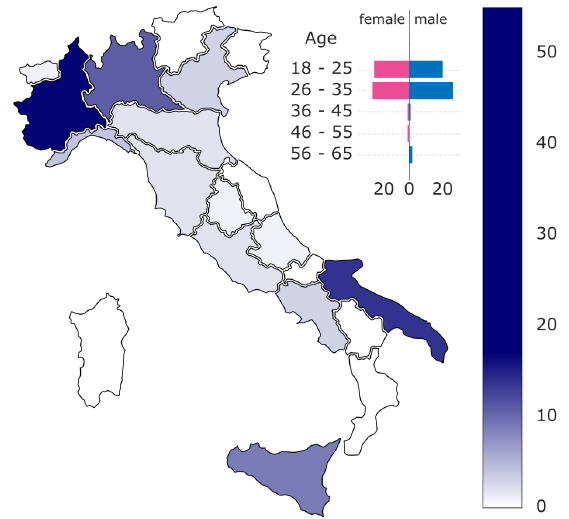
Fig. 1: Survey sample population